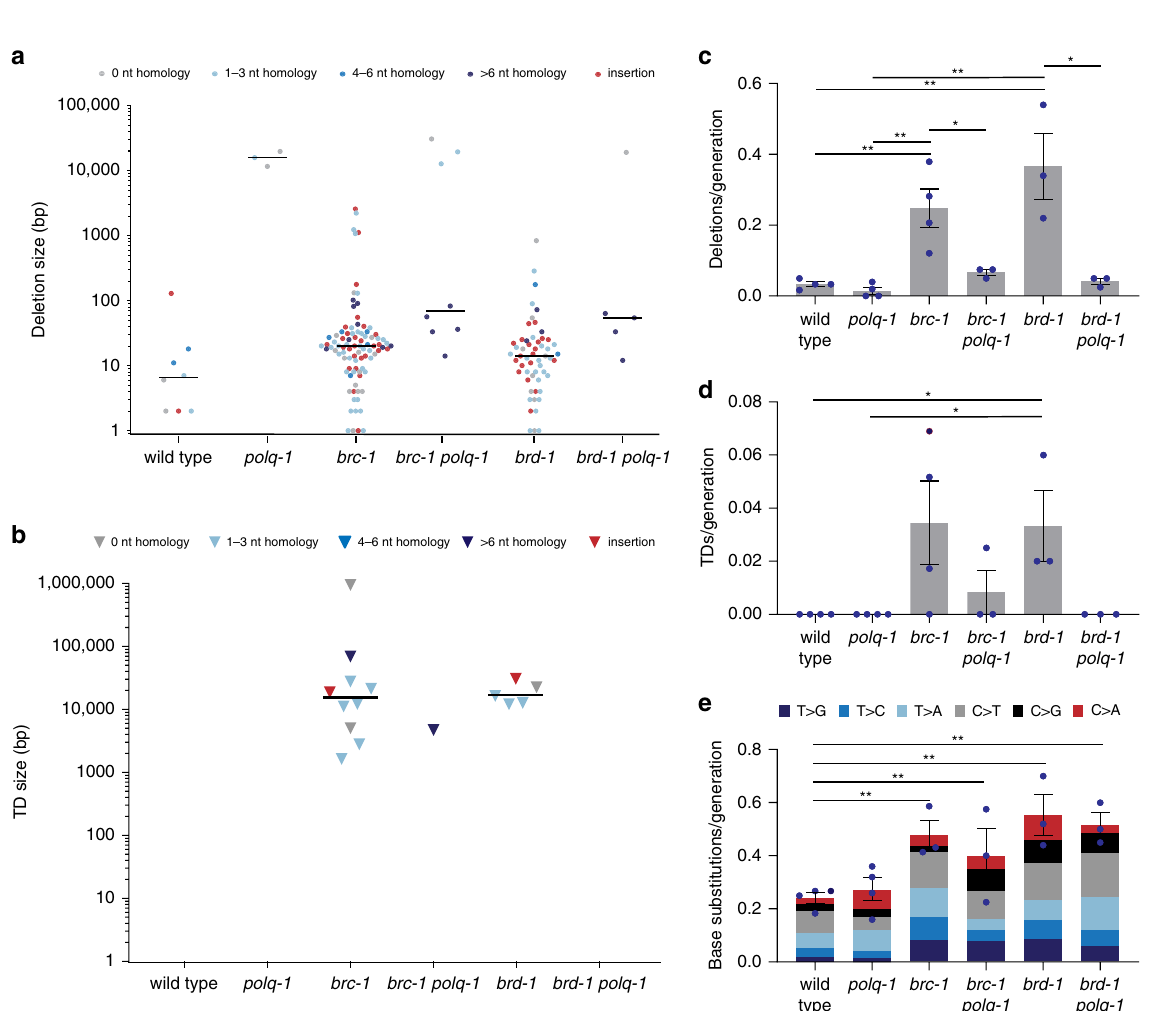
Fig. 3 Knockout of polymerase theta alters deletion and TD rate and homology usage. a Size and junction representation of deletions that were obtained in wild-type and mutant animals ( polq-1 : n = 4, brc-1 polq-1 and brd-1 polq-1 : n = 4). Deletions without homology are shown in grey, deletions with homology are marked in blue. Increasing homology size is depicted in increasing colour intensity. Deletions with insertions are marked in red. The median deletion sizes are indicated by horizontal lines. b Size and junction representation of tandem duplications (TDs) that were obtained in wild-type and mutant animals. TDs with homology at the junctions are marked in blue. Increasing homology size is depicted in increasing colour intensity. TDs with insertions are marked in red. The median TD sizes are indicated by horizontal lines. c Quanti fi cation of the average rate of deletions per generation in animals of different genotypes. The rate is de fi ned as the number of deletions divided by the number of propagated generations per animal. The rate per strain is represented in blue dots. Two-tailed t -tests were used to determine statistical signi fi cance (* P < 0.05, ** P < 0.01). d A quanti fi cation of the average rate of TDs per generation in animals of different genotypes. The rate per strain is represented in blue dots. The rate is de fi ned as the number of TDs divided by the number of propagated generations per animal. Two-tailed t -tests were used to determine statistical signi fi cance (* P < 0.05, ** P < 0.01). e Representation of base substitution type and the average rate of base substitutions per generation in animals of different genotypes. The different types of base substitutions are labelled with different colours. The rate is de fi ned as the number of base substitutions divided by the number of propagated generations per animal. The rate per strain is represented in blue dots. Two-tailed t -tests were used to determine statistical signi fi cance (* P < 0.05, ** P < 0.01). Error bars represent SEM. Wild type: n = 4 of 60 generations, polq-1: n = 4 of 50 generations, brc-1: n = 6 of 58 generations, brd-1: n = 3 of 50 generations, brc-1 polq-1 and brd-1 polq-1 : n = 3 of 40